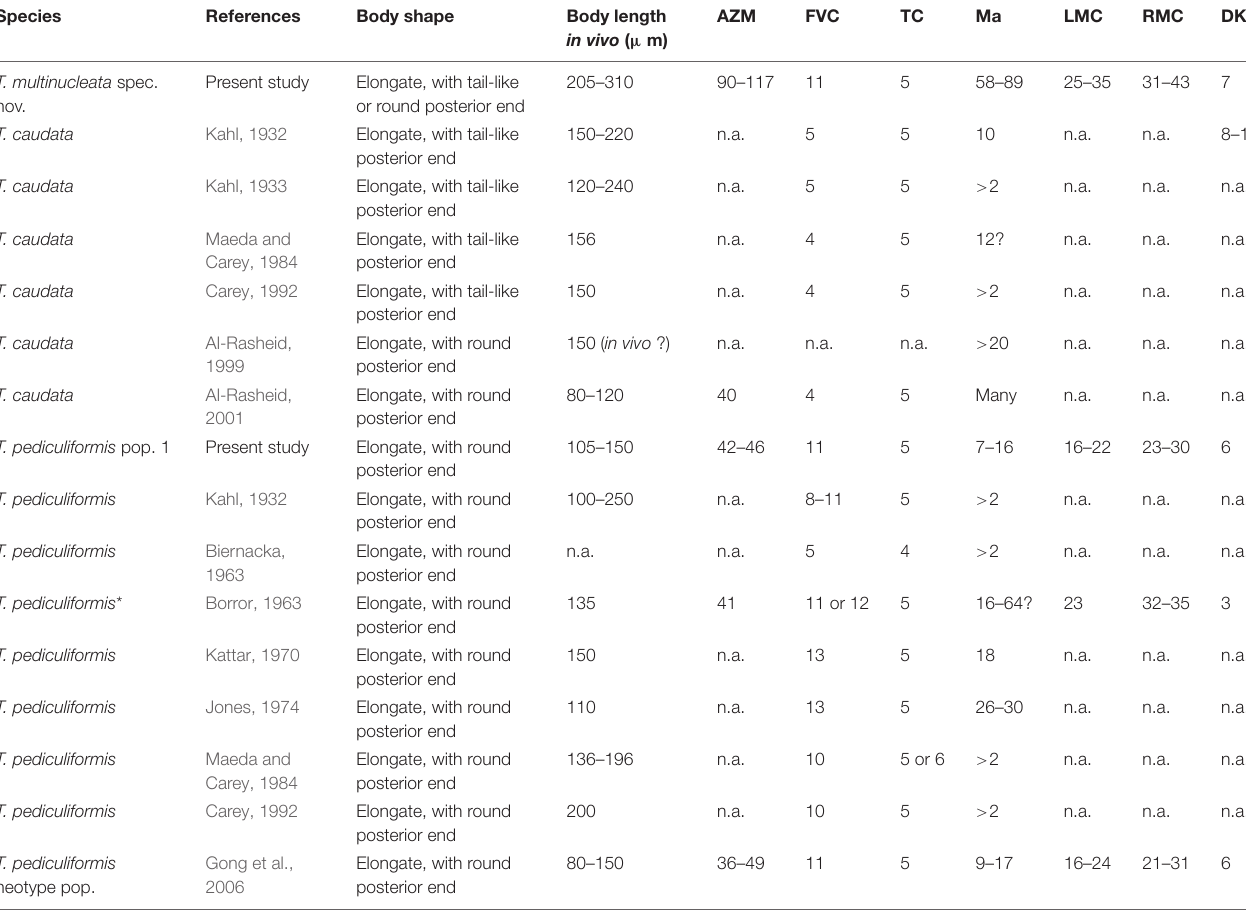
TABLE 3 | Morphological comparison of some selected Trachelostyla species/populations. Species